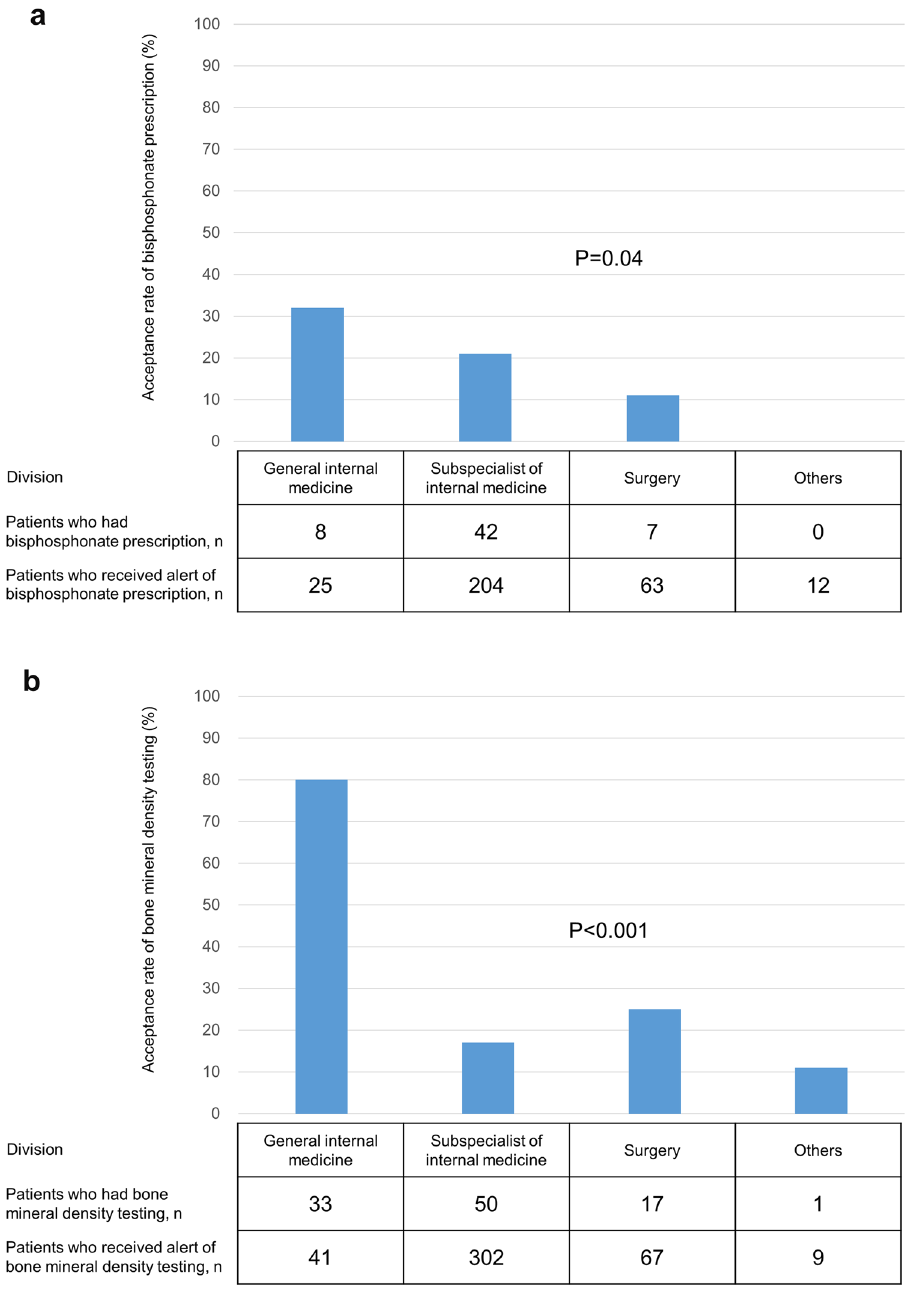
Figure 3. Acceptance rate of alerts for prevention of glucocorticoid-induced osteoporosis stratified by division. ( a ) Bisphosphonate prescription. ( b ) Bone mineral density